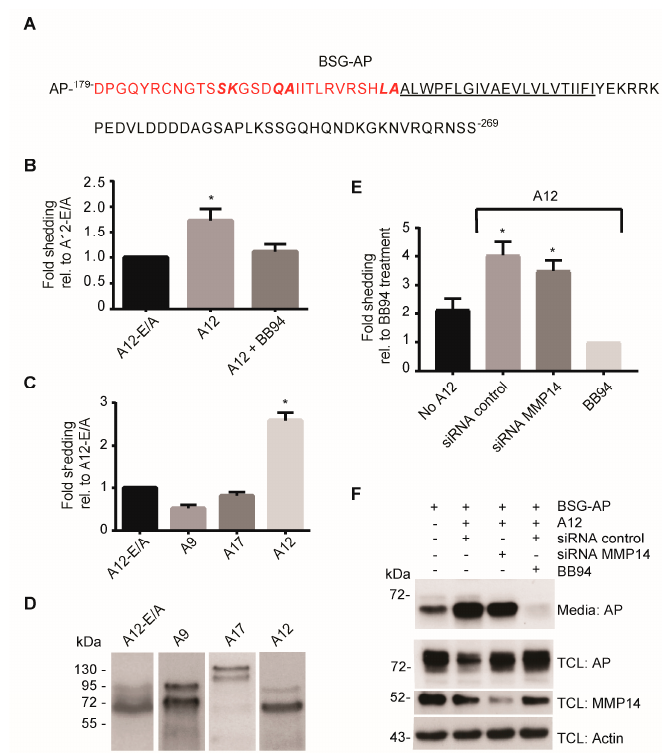
Figure 2. ADAM12 overexpression increases ectodomain shedding of a truncated BSG reporter substrate. ( A ) Amino acid sequence of the reporter substrate BSG-AP, consisting of the C-terminal part of BSG fused to alkaline phosphatase (AP). The truncated extracellular part of BSG is shown in red and the transmembrane domain is underlined. ( B ) Fold shedding in 293-VnR cells transfected with BSG-AP together with A12 or catalytically inactive A12-E/A, and treated with or without the metalloproteinase inhibitor Batimastat (BB94). Fold shedding is calculated as AP activity in the medium divided by the total AP activity in medium and cell lysate, and normalized to A12-E/A. ( C ) Fold shedding in 293-VnR cells transfected with BSG-AP and A12-E/A, A12, ADAM9 (A9) or ADAM17 (A17), calculated as in (C). ( D ) Western blot of total lysates from cells used in (C), showing comparable expression of the different ADAMs. ( E ) Fold shedding in 293-VnR cells transfected with BSG-AP alone (no A12) or with BSG-AP and A12 together in cells treated with control siRNA, siRNA against matrix metalloproteinase (MMP)-14, or the inhibitor BB94 as indicated. ( F ) Western blot of media and total cell lysates (TCL) from cells in (E), using actin as the loading control. For all graphs, values represent means ± SEM from three independent experiments. * p < 0.05, ANOVA.